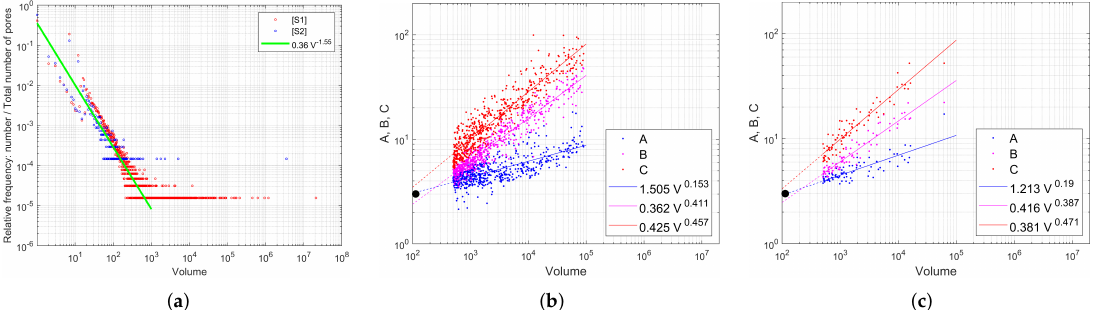
Figure A1. Distribution of the individual pore volumes in [S1] (red) and [S2] (blue) ( a ). Semi-axes of macropores deduced from the moments of inertia as functions of the pore volume, in [S1] ( b ) and [S2] ( c ). All distances are in voxel-size units. The black dots in ( b , c ) correspond to spheres with radius R c , s